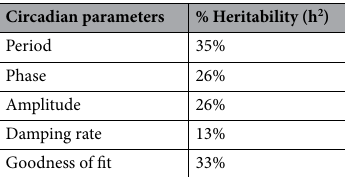
Table 1. Heritability estimates of circadian parameters of Bmal1-dLuc rhythms in cultured fibroblasts derived from the founder strains.